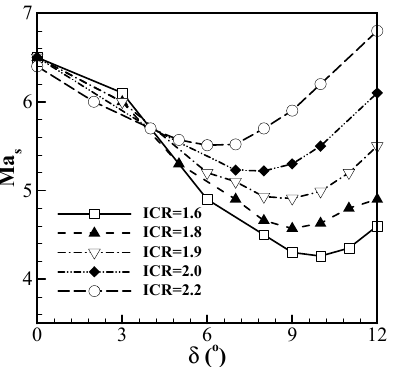
Figure 14. Effects of the cowl lip angle on starting performance of inlets with various ICRs.